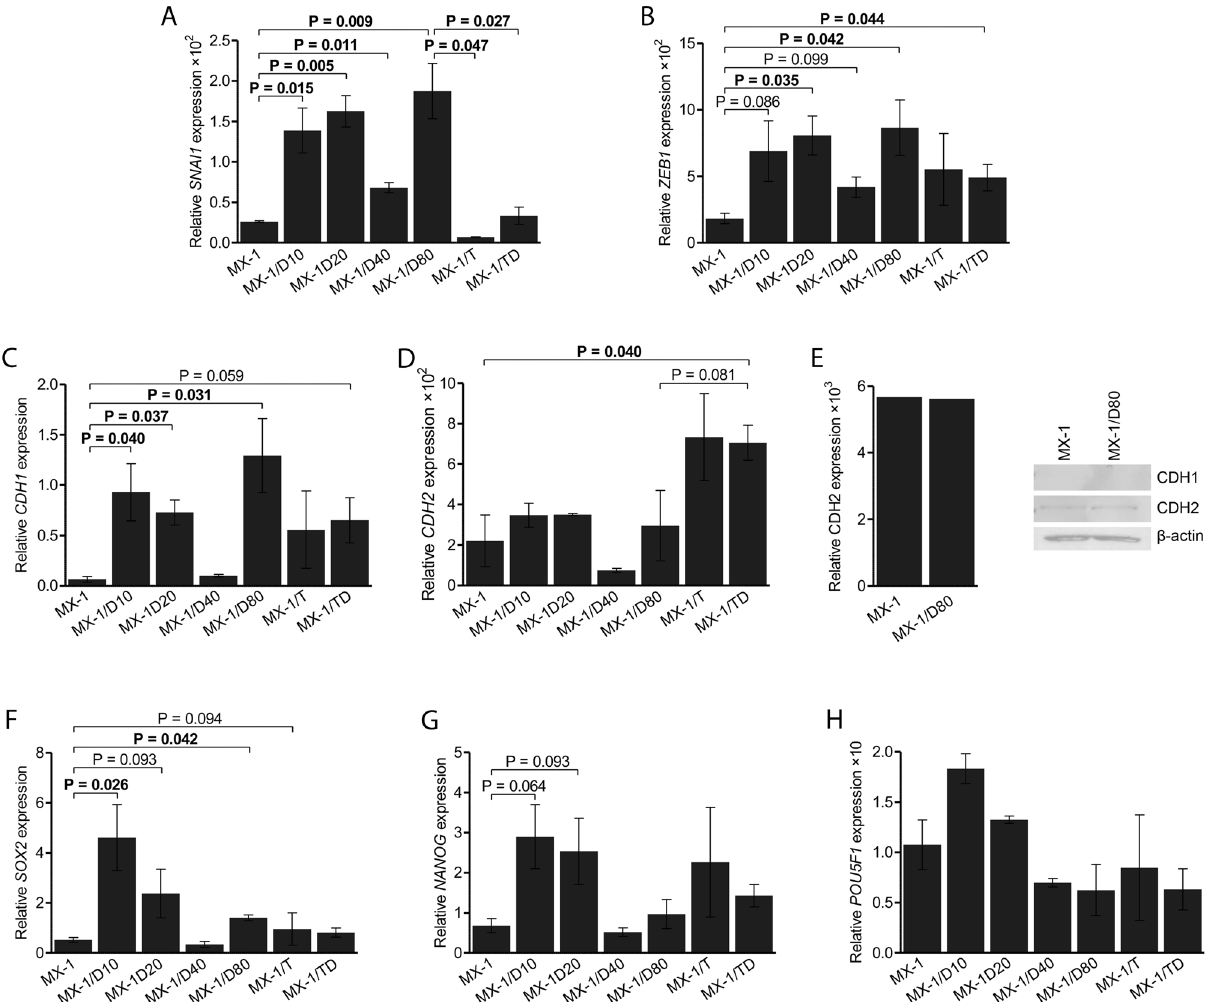
Figure 3. Differential gene expressions of the chemoresistant MX-1 cell sublines. ( A–D ) Results from quantitative PCR (qPCR) analysis showing the comparative mRNA expression of Epithelial–mesenchymal transition related genes in the parental MX-1 and chemoresistant cells, cultured with increasing concentrations (10 nM, 20 nM, 40 nM and 80 nM) of doxorubicin (MX-1/D), ABCB1 transporter activator TPP + (MX-1/T) or both (MX-1/TD). ( E ) Western blot analysis of the protein expression of CDH1 and CDH2 in MX-1 and MX-1/ D80 cells. ( F–H ) Relative expression level of cancer stem cells related genes. The graphs show the mean (± SEM) ratio of the indicated gene expression compared to endogenous control HPRT1 expression. Indicated P values were calculated based on paired